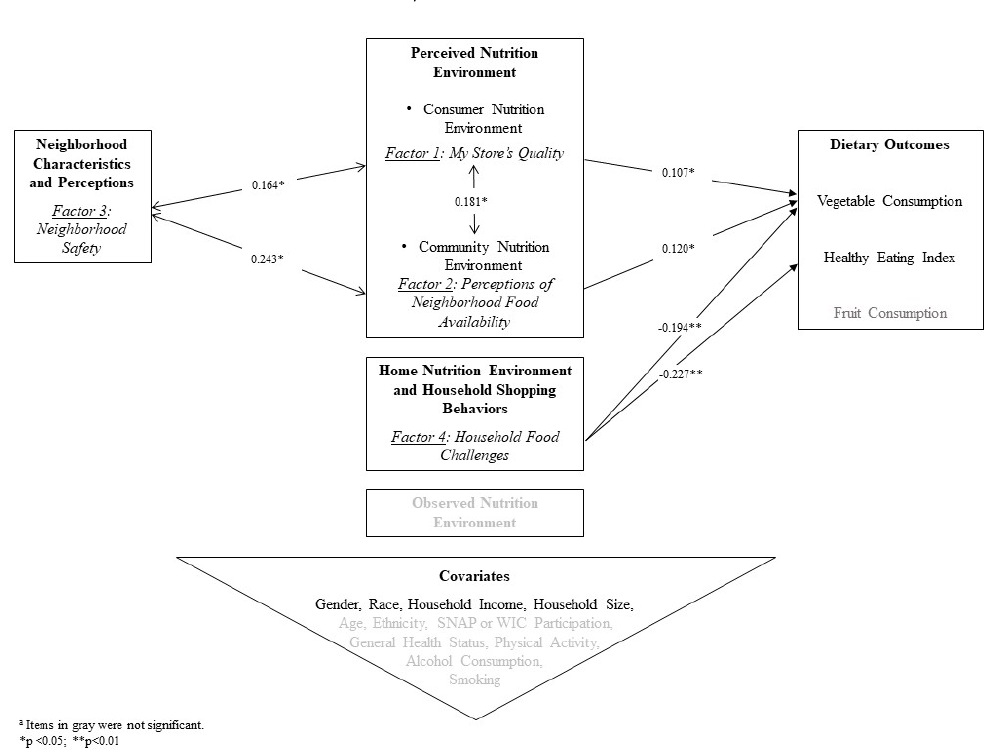
Figure 2. Identified Pathways Among Key Factors Which Contributed to Dietary Outcomes in Urban Food Desert Communities a.